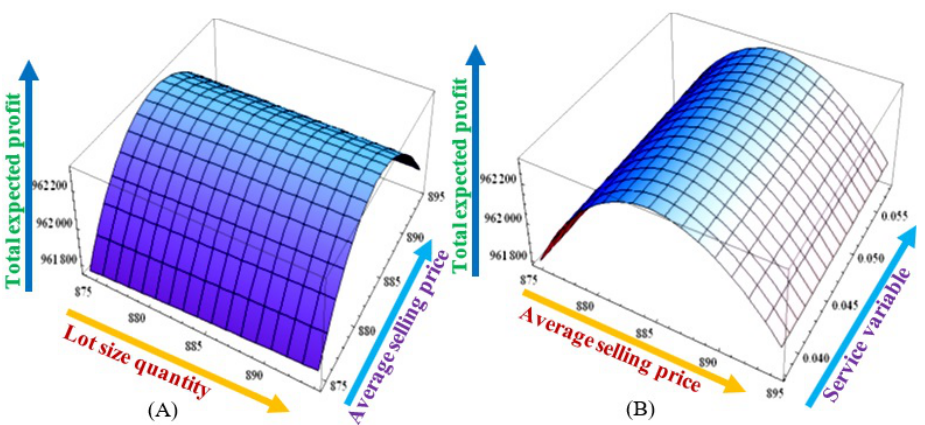
Figure 3. TEP as a function of ( a ) production rate and average selling price; ( b ) production rate and lot size quantity.